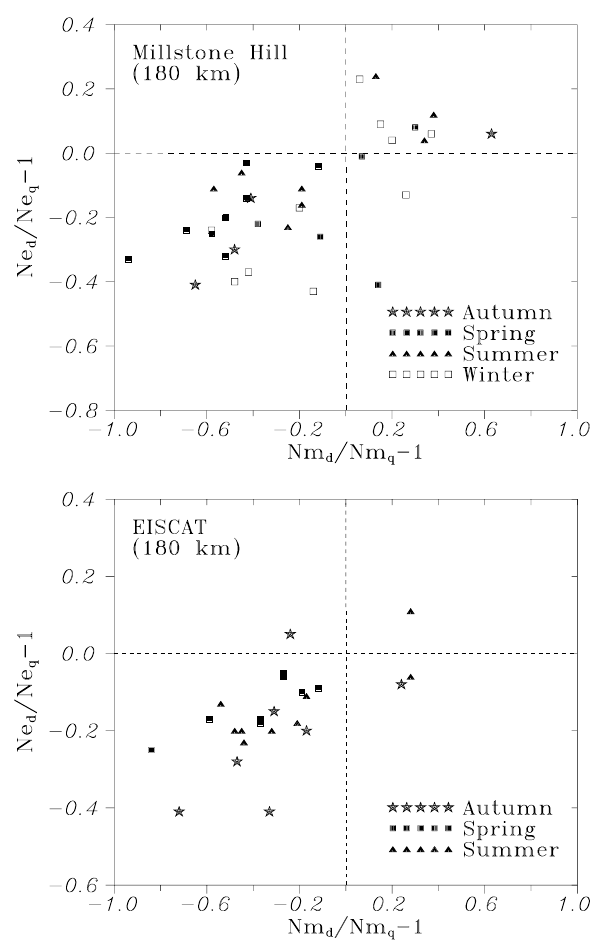
Fig. 1. The relative (disturbed/quiet) deviations δNe at 180km ver- sus relative deviations δNm F2 for Millstone Hill and EISCAT storm